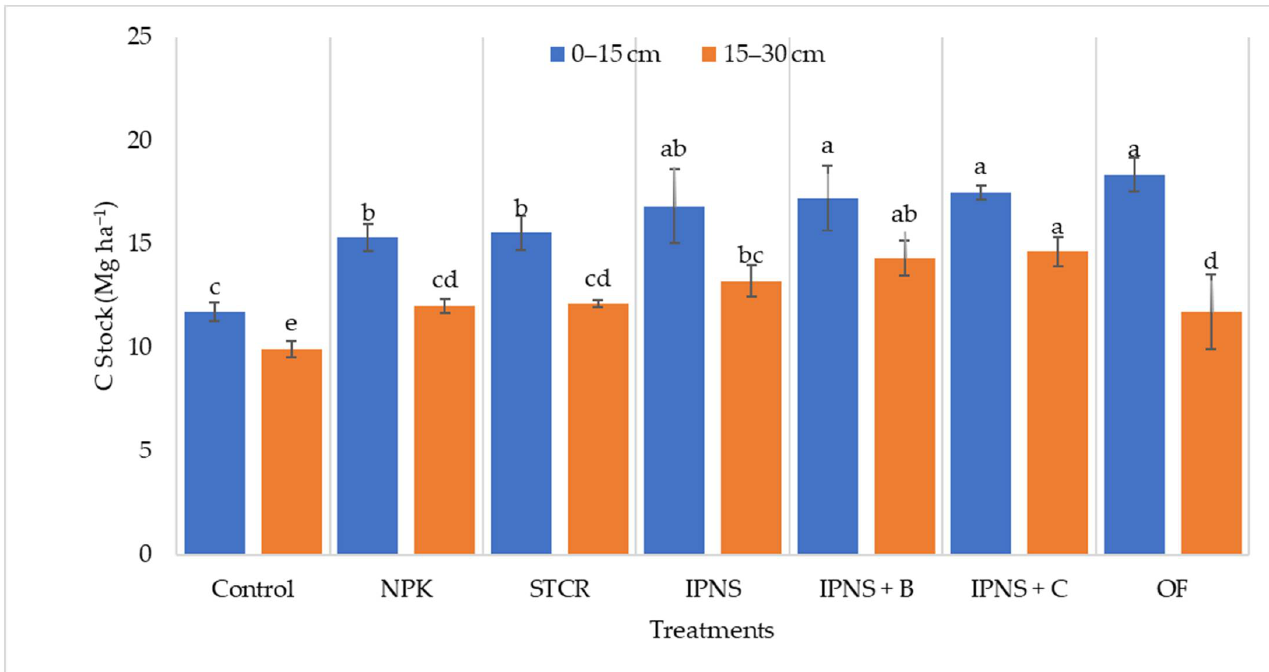
Figure 11. Effect of nutrient management on C-stock contribution. Means ± standard deviation of different treatments followed by the different lower-case letter (a–e) are significantly different at p < 0.05 level of significance according to DMRT.